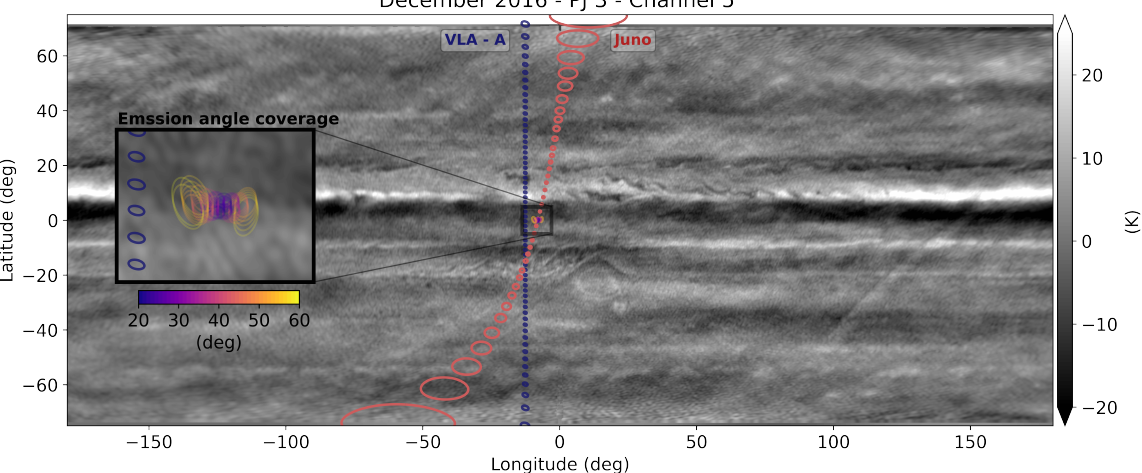
Figure 9. VLA longitude-resolved map at 3 cm (8–12 GHz) taken concurrently with the Juno PJ3 flyby in December 2016. The VLA was in its most extended (A) configuration. The red footprints correspond to MWR’s Channel 5 observation (3 cm), and the blue footprints correspond to the VLA resolution. The inset shows an enlargement of the indicated region with all 60 individual observations colorized by their beam-convolved emission angle. For more details, see Moeckel et al.